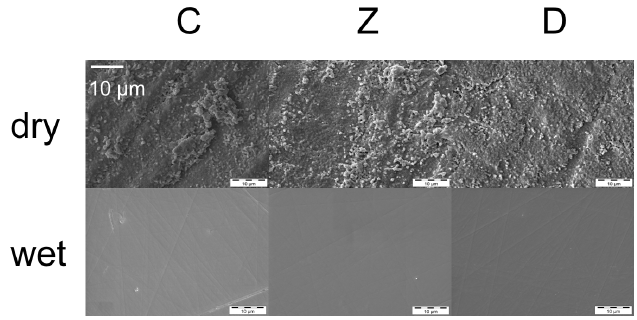
Figure 3. Scanning electron microscopy (SEM) pictures of dry and wet ground zirconia materials.